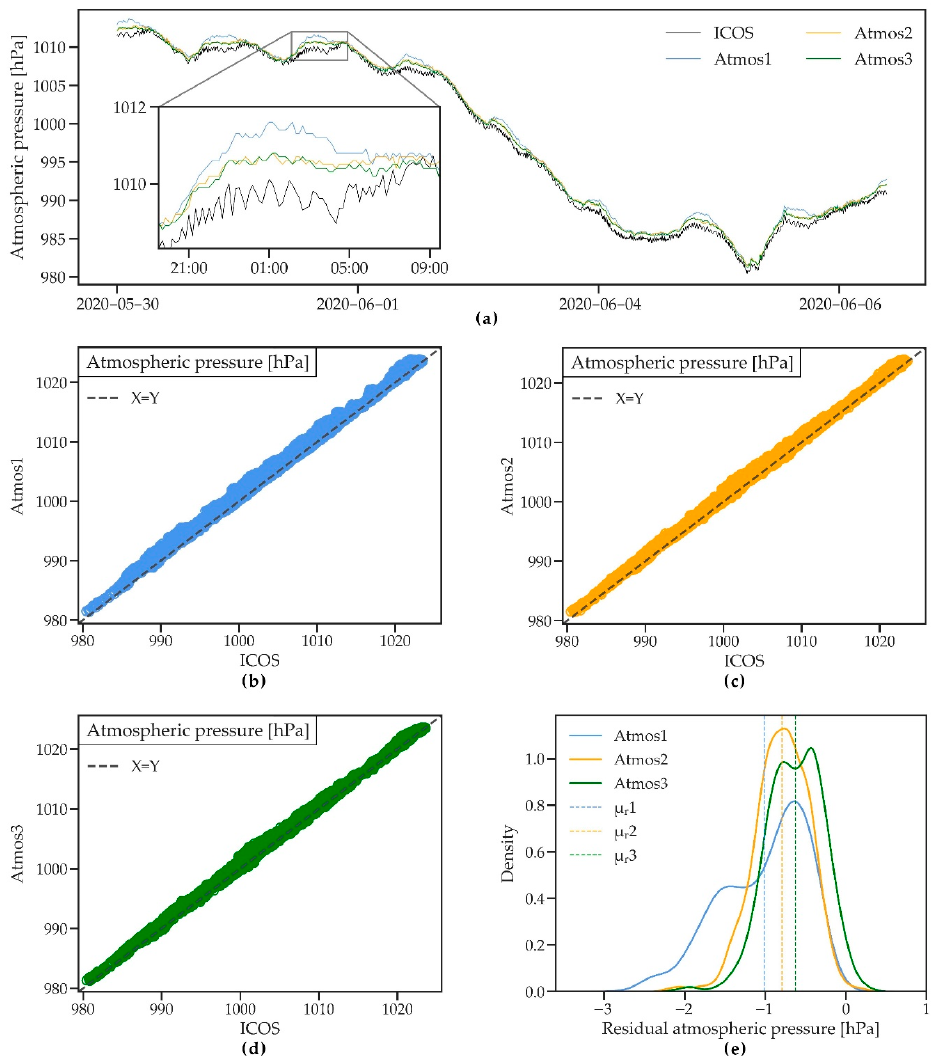
Figure 7. ( a ) A short time series of atmospheric pressure measured by three ATMOS41 weather stations and the ICOS-bkp station from 30 May to 6 June 2020. ( b – d ) Scatterplots of 10 min atmospheric pressure for the three ATMOS41 stations vs. the reference station. ( e ) Probability density functions of the residual mean hourly atmospheric pressure. Dashed lines show the mean of residuals ( μ r ).